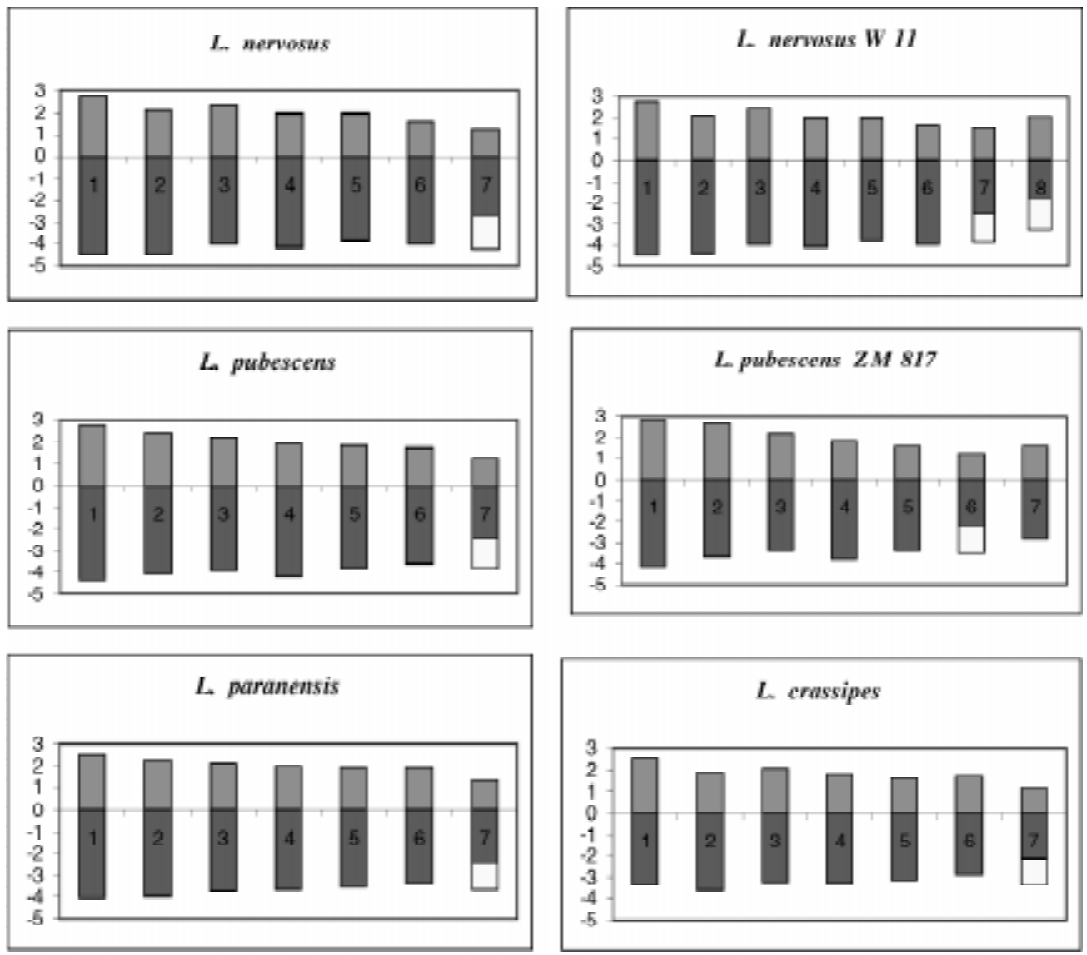
Figure 2 - Idiograms of the four Lathyrus species, showing the polymorphism in L. nervosus and L. pubescens. In L. nervosus W 11 the chromo- somes numbered 7 and 8 represent the polymorphism of the satellited pair. Vertical scale in m m.